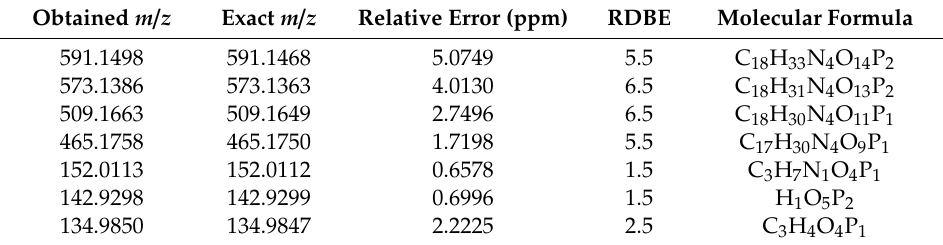
Table 6. The relative error (ppm) and RDBE for each fragment produced from the MS / MS analysis. Obtained m / z Exact m / z Relative Error (ppm)